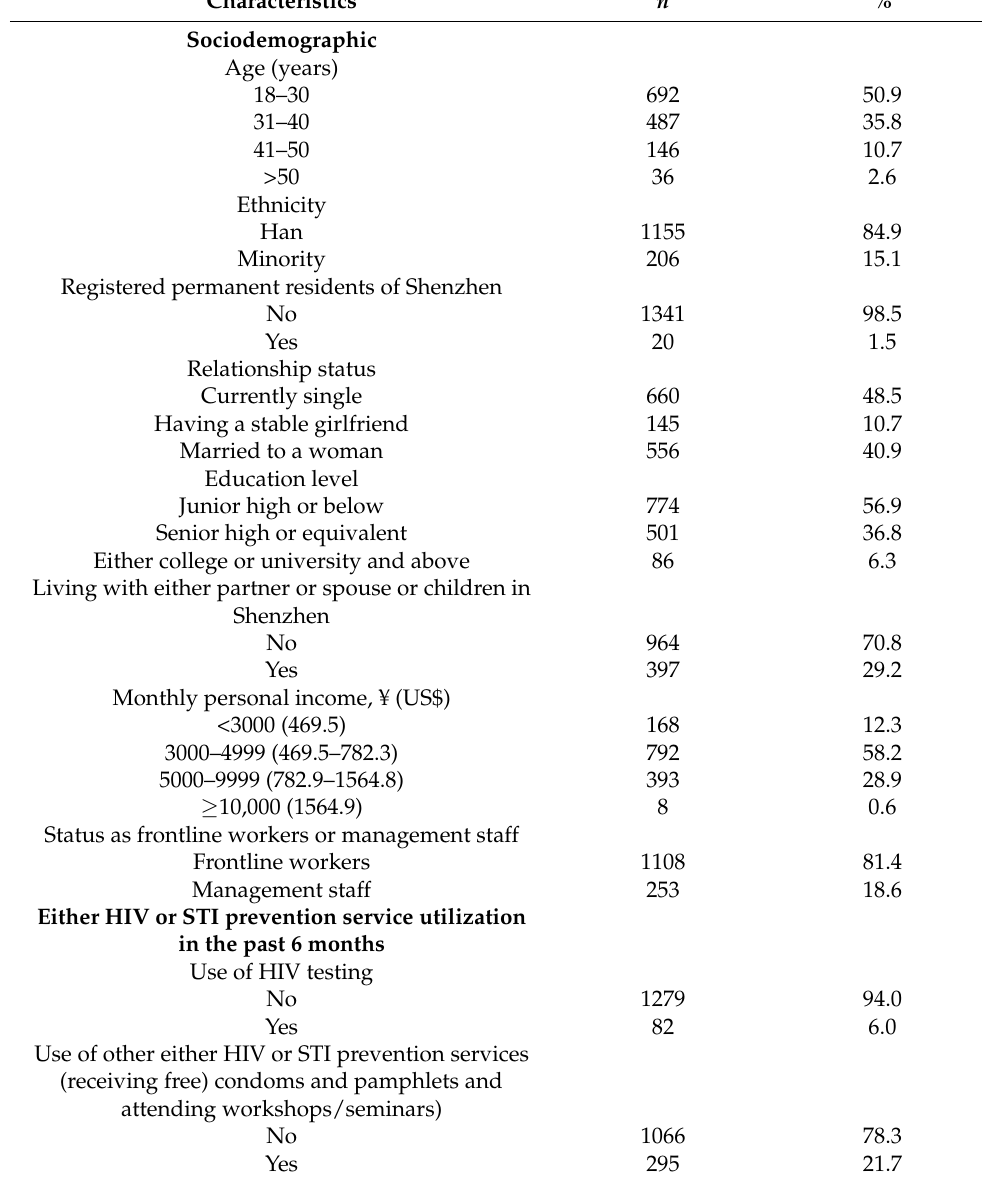
Table 1. Background characteristics and sexual behaviors of the participants ( n =